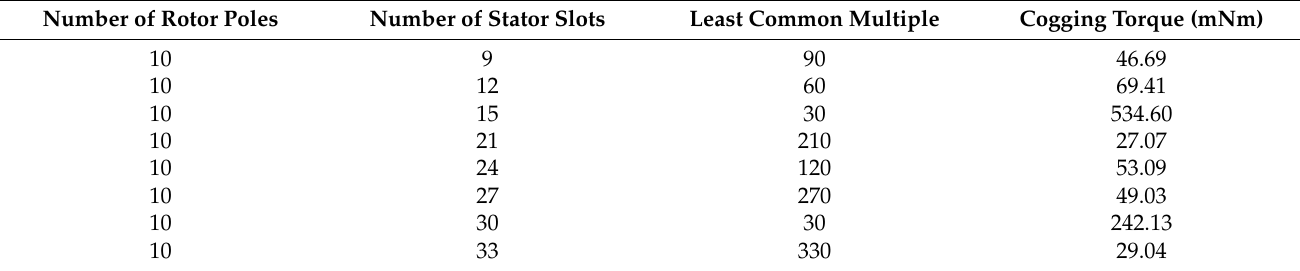
Table 7. The magnitudes of cogging torque under different numbers of stator slots when the number of rotor poles is 10. Number of Rotor Poles